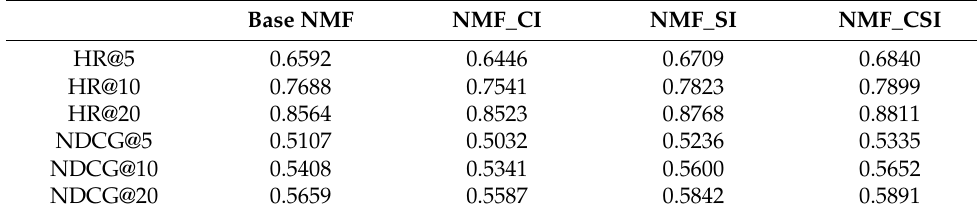
Table 2. Results of models reflecting domain information.